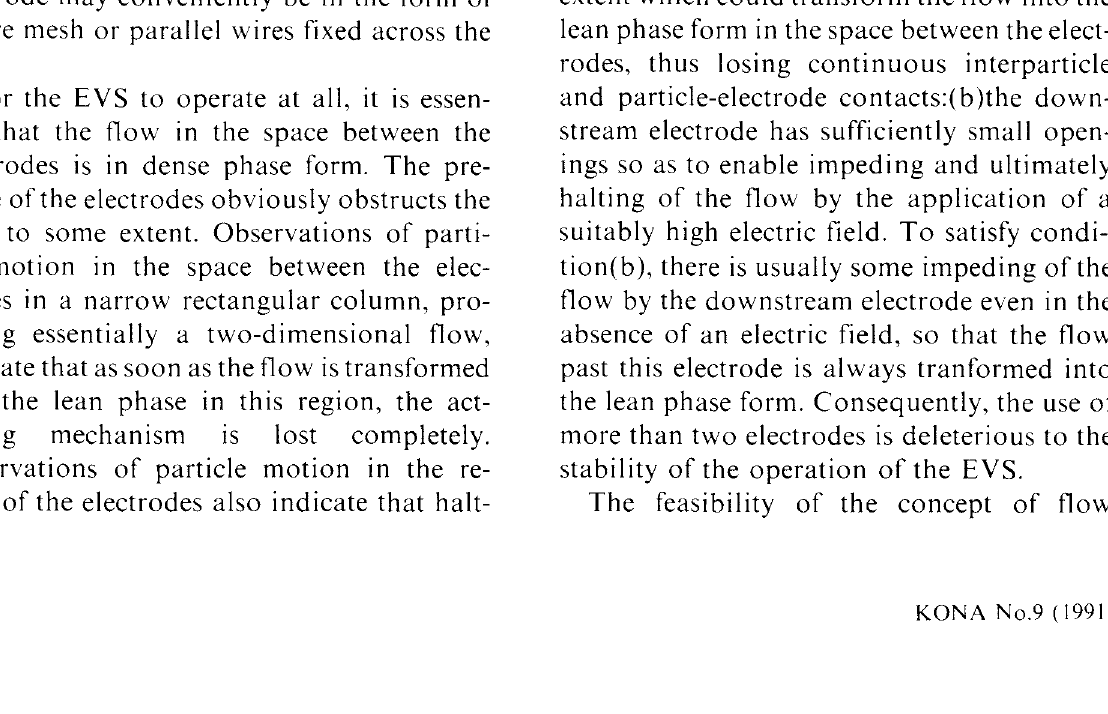
Fig.l Typical electrode configurations of the EVS in cylindrical and rectangular